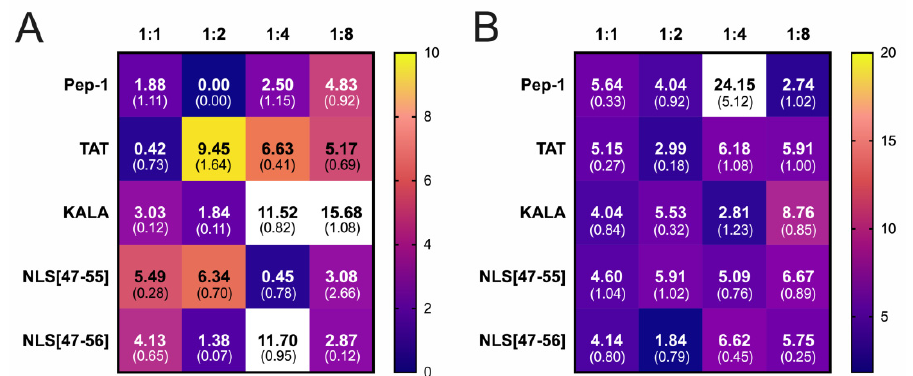
Figure 7. Effect of 24 h culture in the presence of complexes in CRs of 1:1, 1:2, 1:4 and 1:8. The complexes were formed using incubation of 2 μ g pmaxGFP with chosen CPPs at 21 °C for 15 min. CR, charge ratio. ( A ) Transfection efficiency. ( B ) Percent of cells with abnormal morphology. Data are presented as means, numbers in parentheses represent standard deviations.